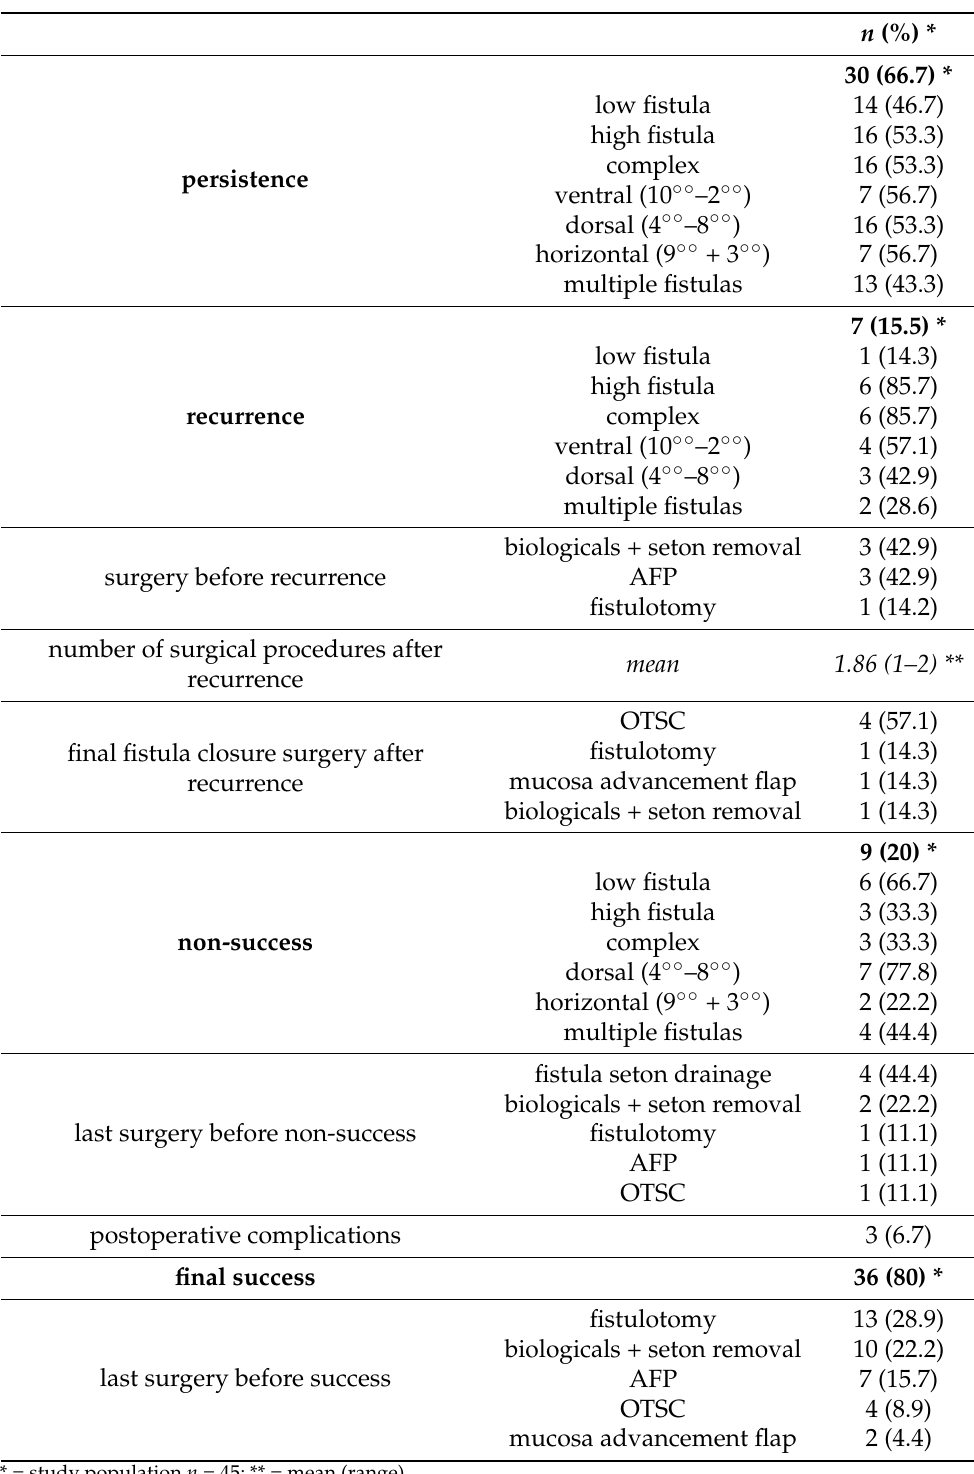
Table 5. Surgical